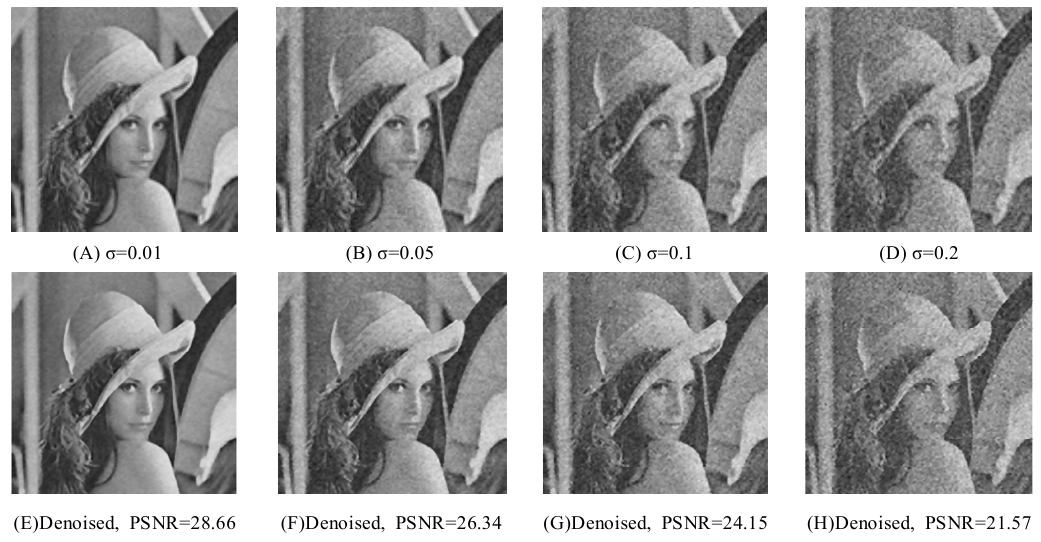
Figure 14. Denosing results of Lena with Gaussian noise using IFOA-DTCWT-BF. ( A ) Lena of noise σ = 0.01; ( B ) Lena of noise σ = 0.05; ( C ) Lena of noise σ = 0.1; ( D ) Lena of noise σ = 0.2; ( E ) Denoised image of σ = 0.01; ( F ) Denoised image of σ = 0.05; ( G ) Denoised image of σ = 0.1; ( H ) Denoised image of σ = 0.2.